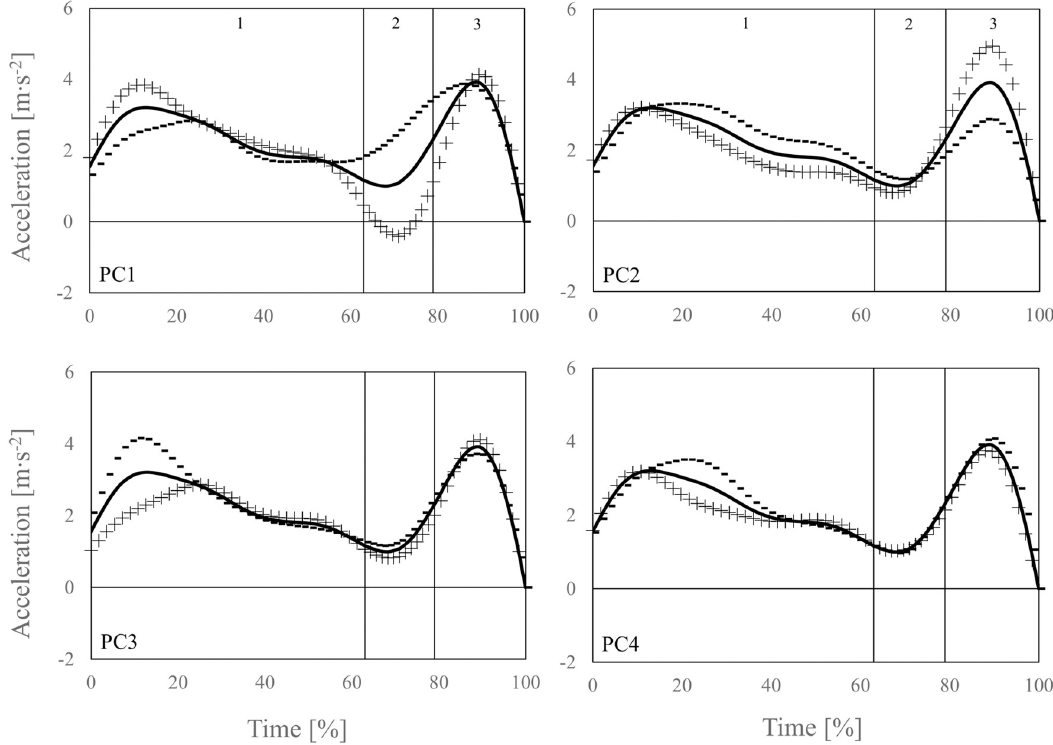
Fig 2. Vertical barbell acceleration data for the acceleration phase (0–100%) of the snatch with the effect of high (+ signs) and low ( − signs) PC scores for PC1-4 on the average acceleration waveform (black solid lines). The numbers 1–3 in the upper graphs separate the 1 st pull, from transition, and 2 nd pull during the acceleration phase.